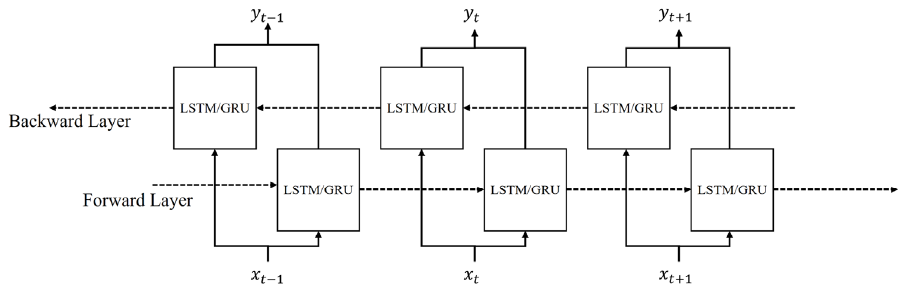
Figure 8. Architecture of Bi-LSTM and Bi-GRU.